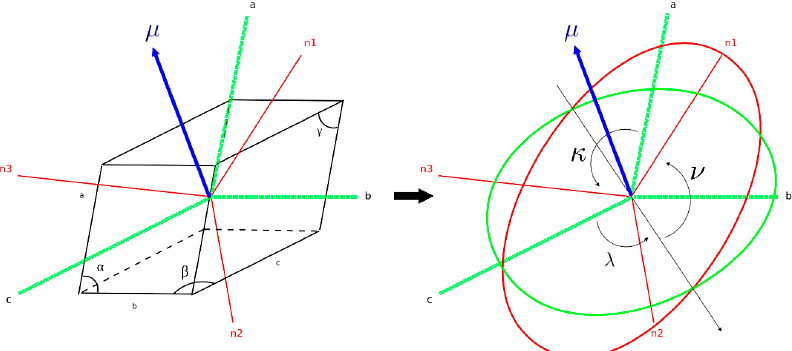
Figure 2. For the example of a triclinic unit cell ( left ), there is no relation between the crystallographic Cartesian axes ( a , b , c ; green) and the principal optical directions ( n 1 , n 2 , n 3 , red). The indicatrix is not shown. A transition dipole moment vector µ in the crystallographic coordinate frame is transformed to the optical frame by Euler rotation (Euler angles κ , λ , ν ; right